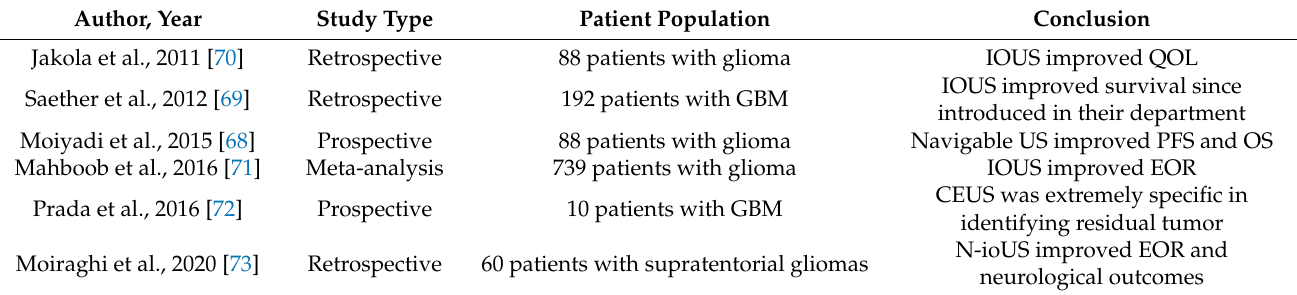
Table 4. Main studies evaluating IOUS in patients with brain tumors.